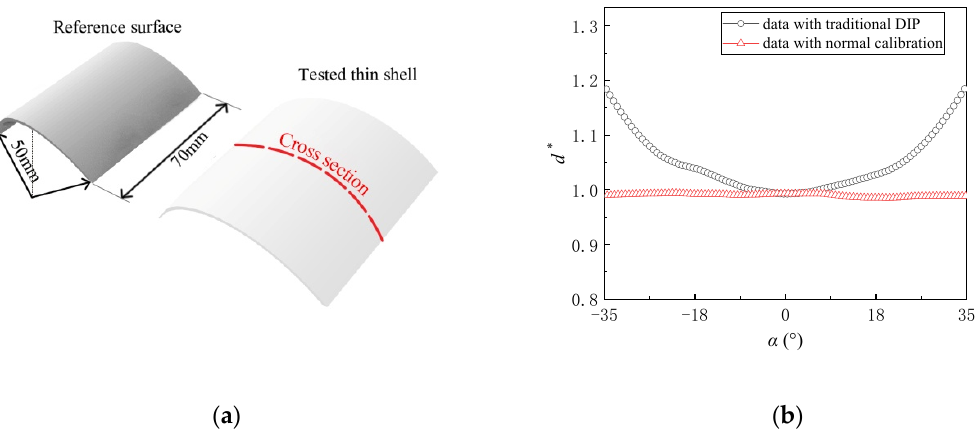
Figure 9. Measurement for a curved shell: ( a ) experimental models; ( b ) results along the central cross section.